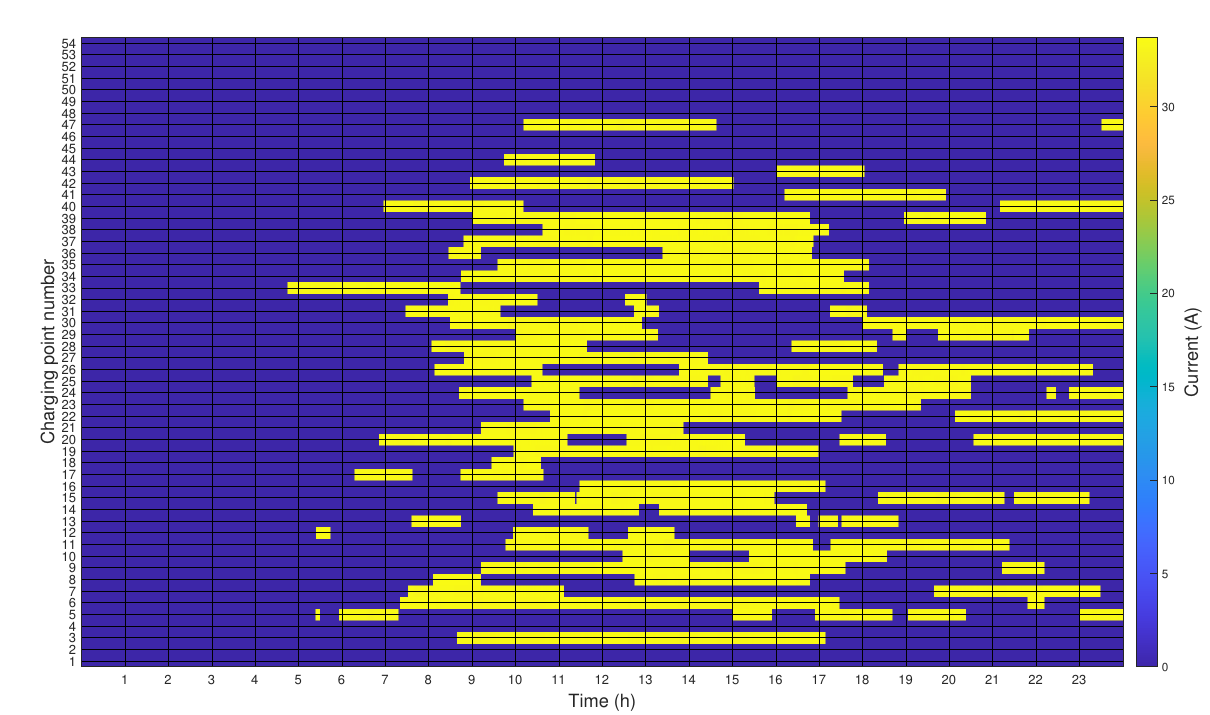
Figure 4. Charging events of the simulated